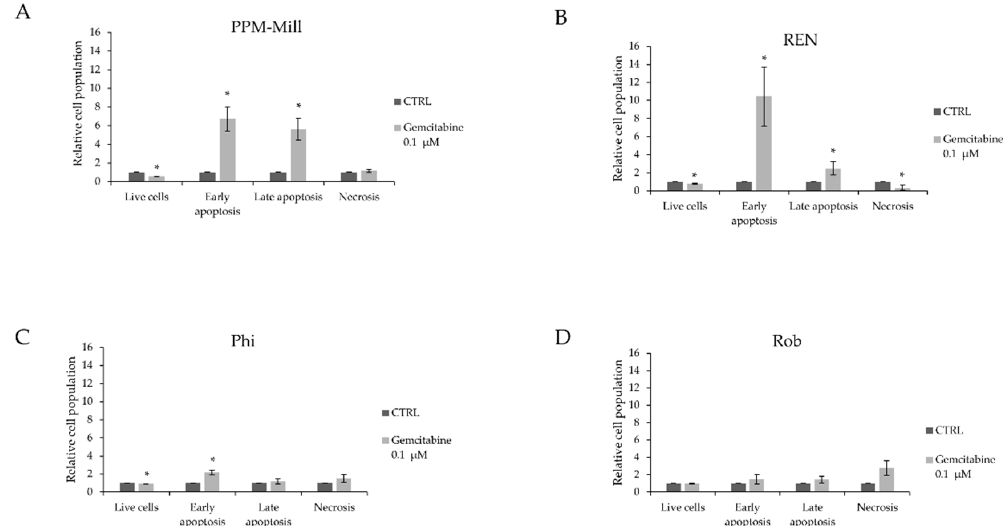
Figure 3. Annexin V assay in PPM-Mill, REN, Phi and Rob cells ( A – D ) treated with either 0.1 µM gemcitabine or DMSO that was used as vehicle (CTRL), for 48 h, conducted using FACS. Statistical analysis is described in Materials and Methods section. * p ≤ 0.05.